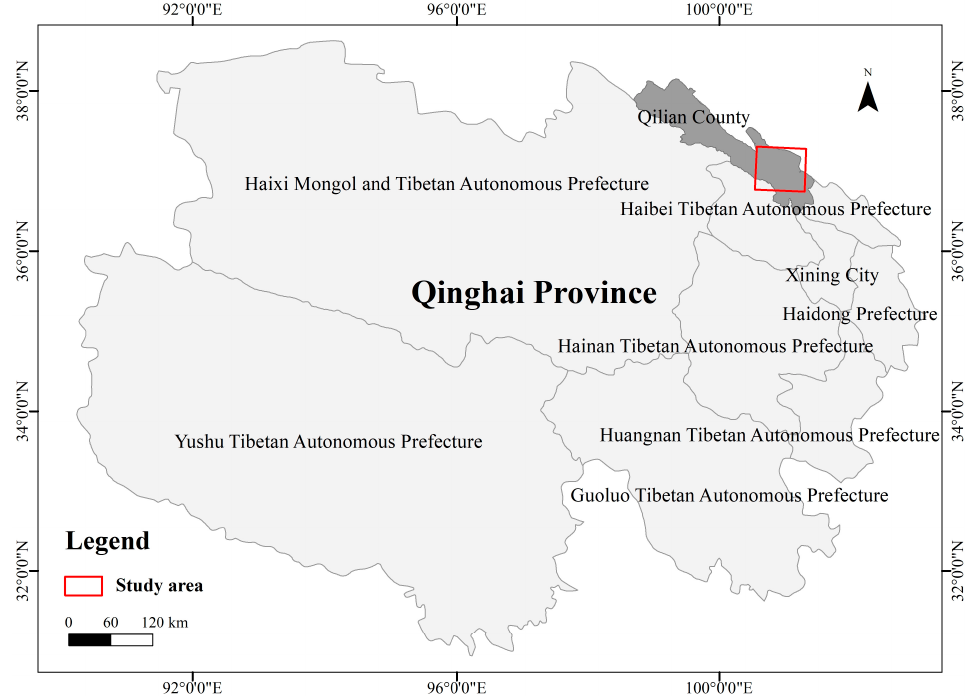
Figure 2. Location of the study area.